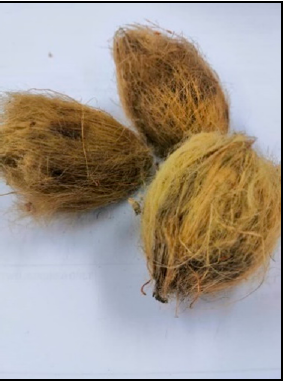
Figure 1. Cleaned arecanut fruit collected from a local farm.